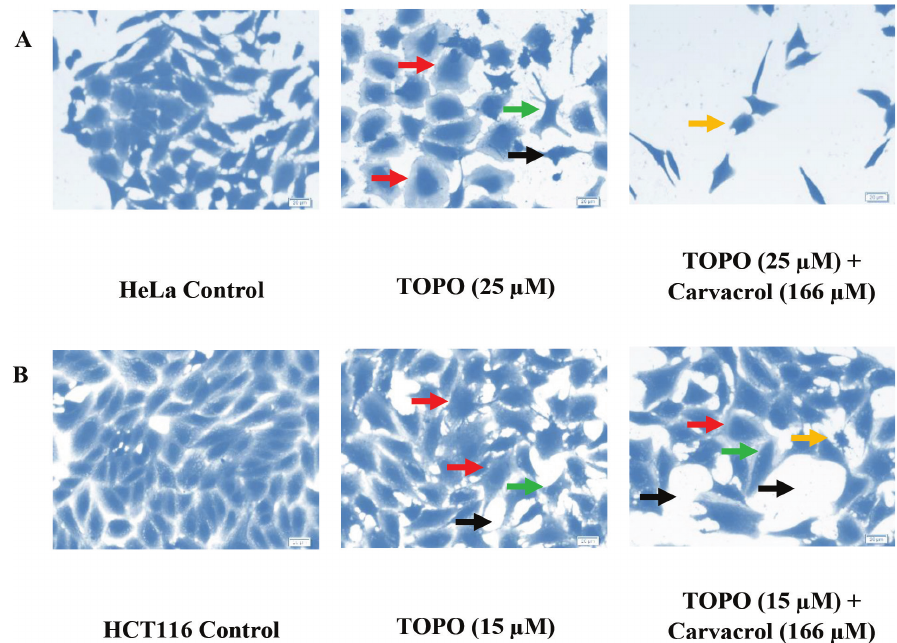
Figure 3. Light microscopy images (Scale bar: 20 µm) of (A) HeLa and (B) HCT116 cell lines treated for 24 h with TOPO IC absence or presence of carvacrol (166 µM). Images were magnified at 20×. The red, green, orange and black arrows represented cell enlargement with cytoplasm shrinkage, membrane blebbing, apoptotic bodies and intercellular space increase, respectively. Images were taken from at least three independent experiments with similar